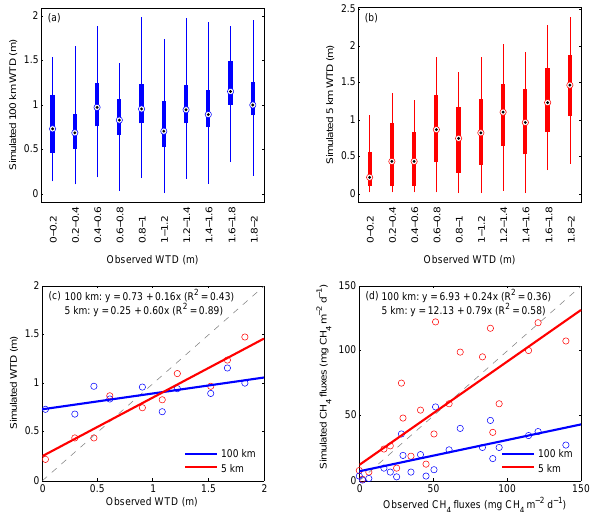
Fig. 3. Comparison of the observed and simulated water table depth (WTD, a – c ) and daily methane fluxes (d) during the growing sea- son (May–September). Observed WTD at well sites ( ∼ 5000 sites across southern Canada), with shallow water tables (<2m below the land surface), are retrieved from Fan et al. (2013). Observed WTD are grouped into 10 bins with a 20cm interval and then compared to the simulated WTD at 100km (a) and 5km (b) spatial resolutions (boxes represent 50% of the data, with median values indicated by circles and the whiskers representing the minimum and maximum), with fitted lines of median values also shown (c) . The observations of methane fluxes are derived from 22 field sites over the pan-Arctic (Table